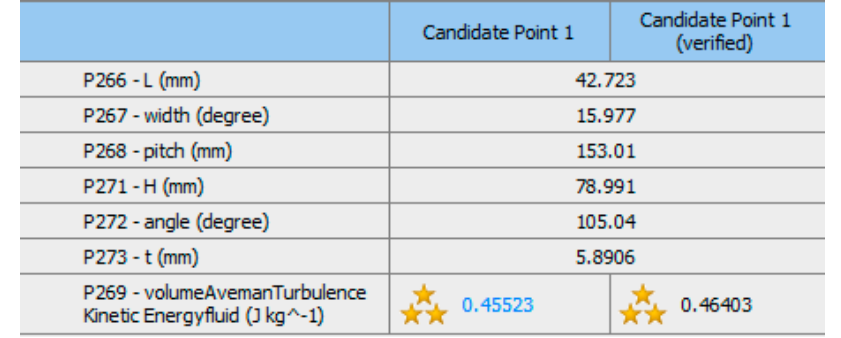
Figure 21. Verification of candidate point recommended from response surface after resetting for